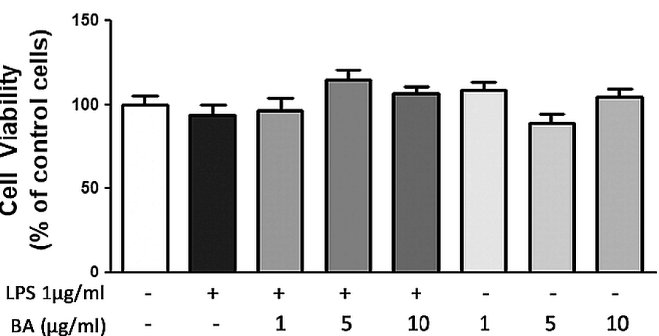
Figure 1. Effects of BA on HT-29 cell viability in presence or absence of LPS. BA was added to the culture medium 30 min before LPS treatment for 4 h. Then, cell viability was assessed by MTT assay.